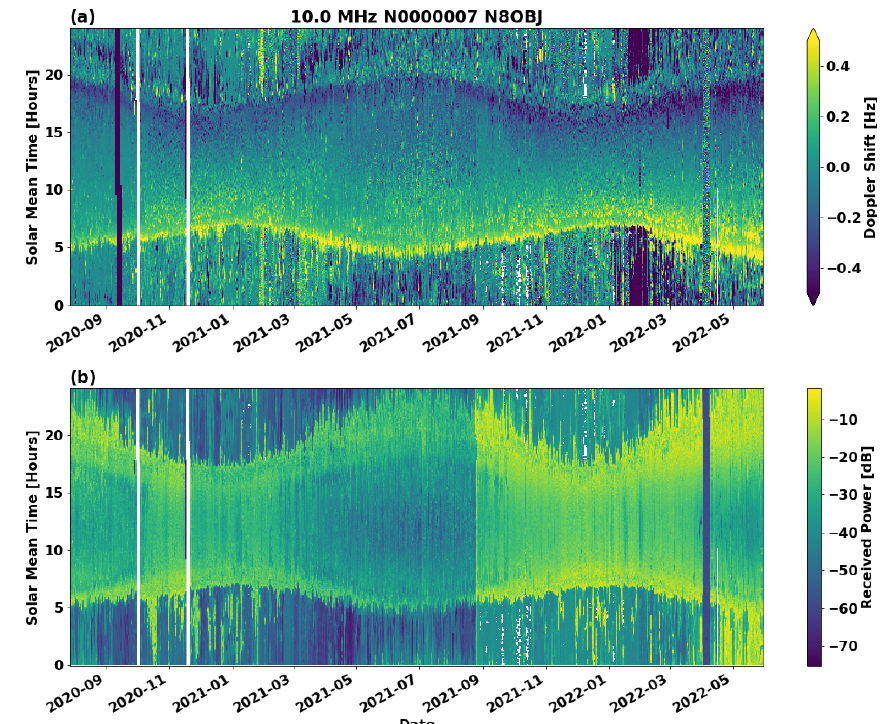
Figure B1. A version of Fig. 6 using the perceptually uniform viridis color map.